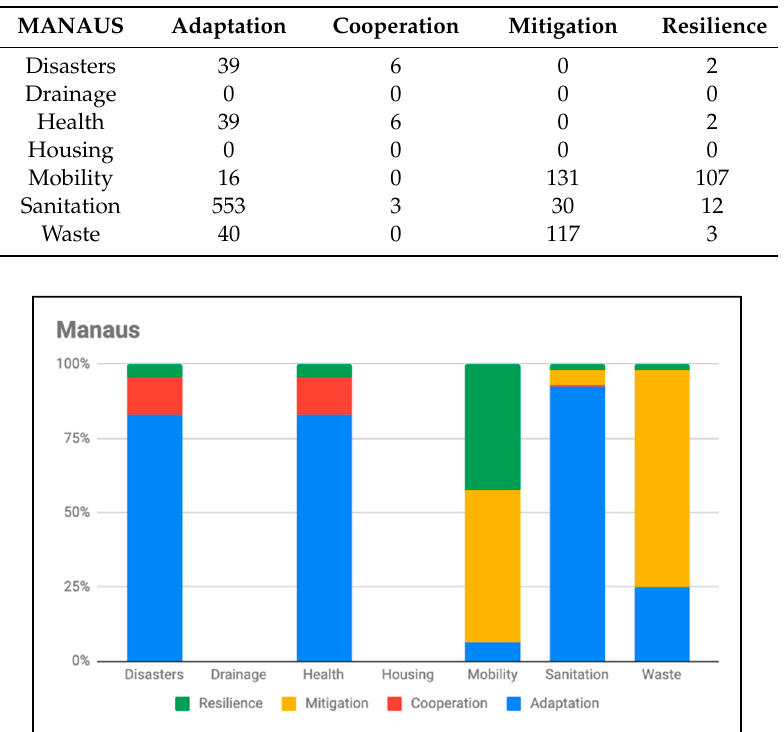
Figure 11. Climate action references in Goiânia’s sectoral plans. Table 11. Climate action references in Manaus’ sectoral plans.